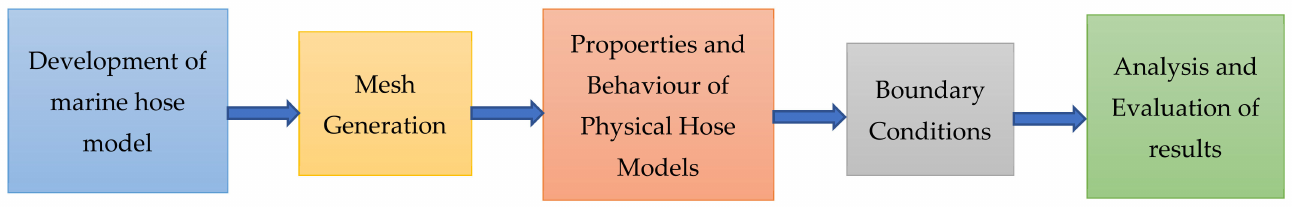
Figure 3. Methodology for the finite element model of the marine bonded composite hose model.